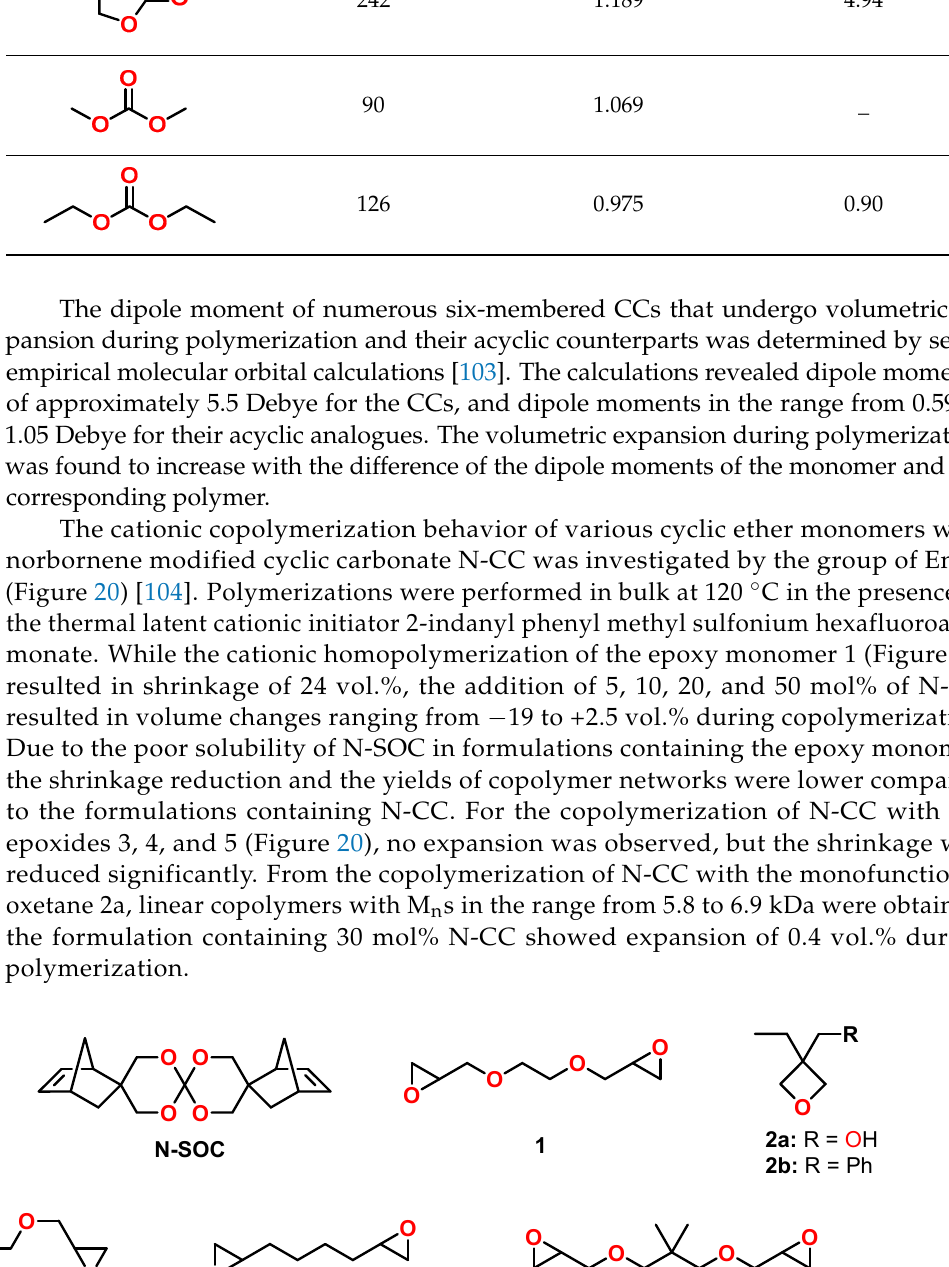
Figure 20. Chemical structure of cyclic ether monomers used for copolymerization with the cyclic carbonate N-CC and the spiroorthocarbonate N-SOC.